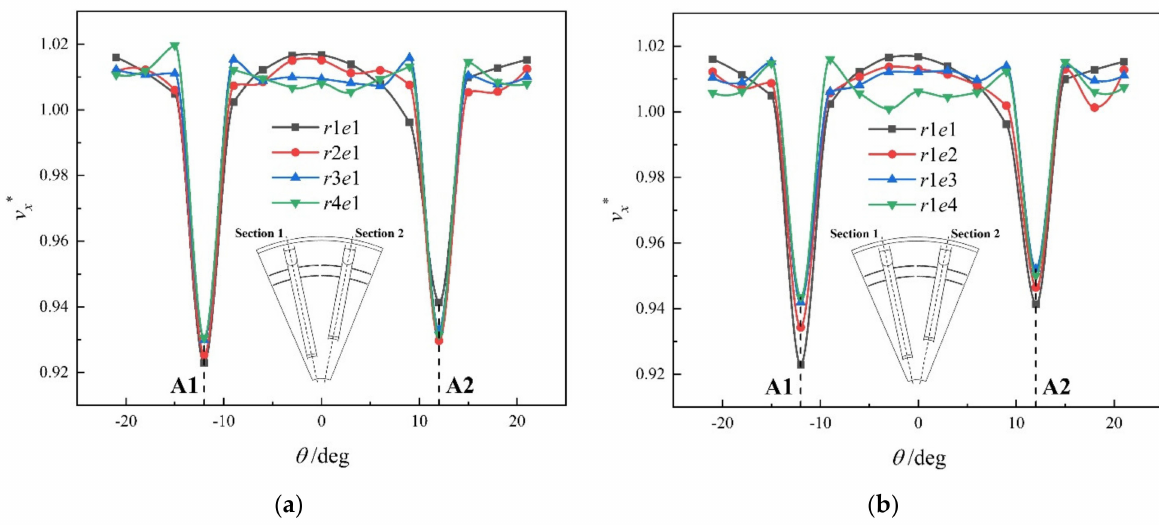
Figure 11. Distribution of inlet velocity coefficient of heat shield under cases with different cooling flow path structure parameters: ( a ) heat shield inlet height r ; ( b ) afterburner annulus height e